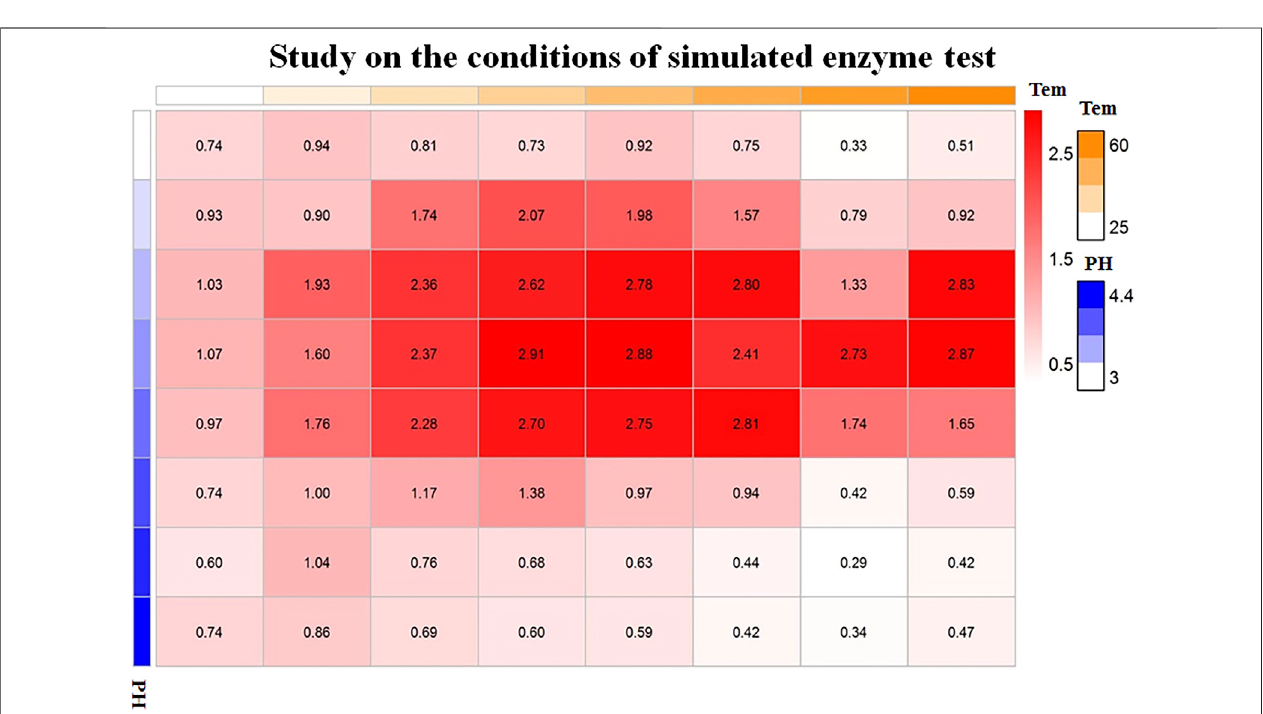
FIGURE 4 | Orthogonal analysis of the pH and temperature of colloidal gold prepared by sodium citrate reduction.